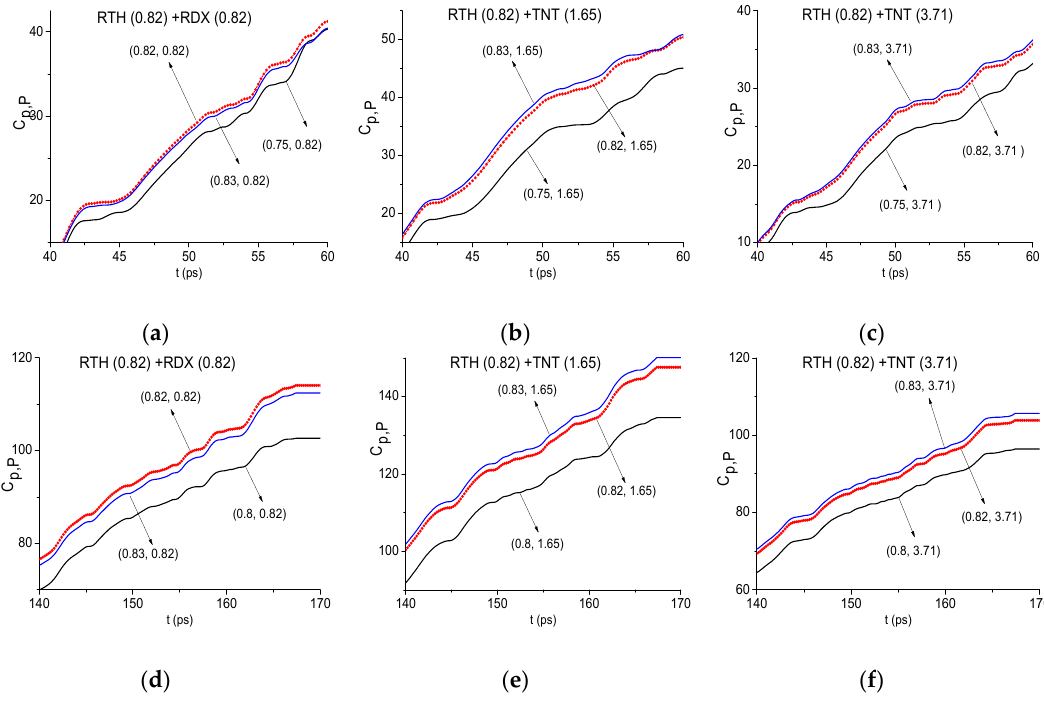
Figure 22. Time-dependent ICC C p , P computed for the dynamics RTH(0.82) and the standard dynamics RDX(0.82) ( a,d ), TNT(1.65) ( b,e ), and TNT(3.71) ( c,f ) in the time intervals t = [40, 60] ps ( a–c ) and [140, 170] ps ( d–f ).